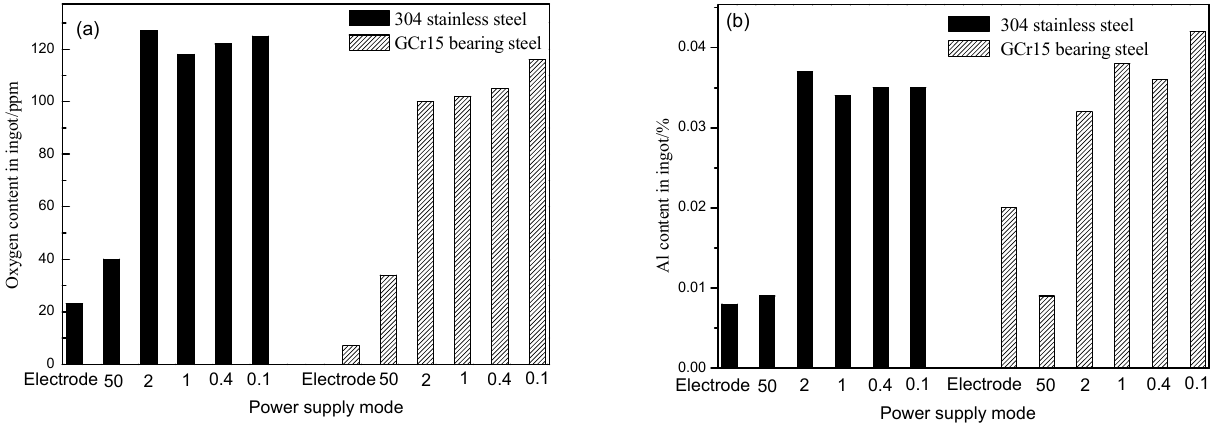
Figure 9. Oxygen and Al content in ingots with different power supply modes. (( a )—Oxygen content; ( b )—Al content).